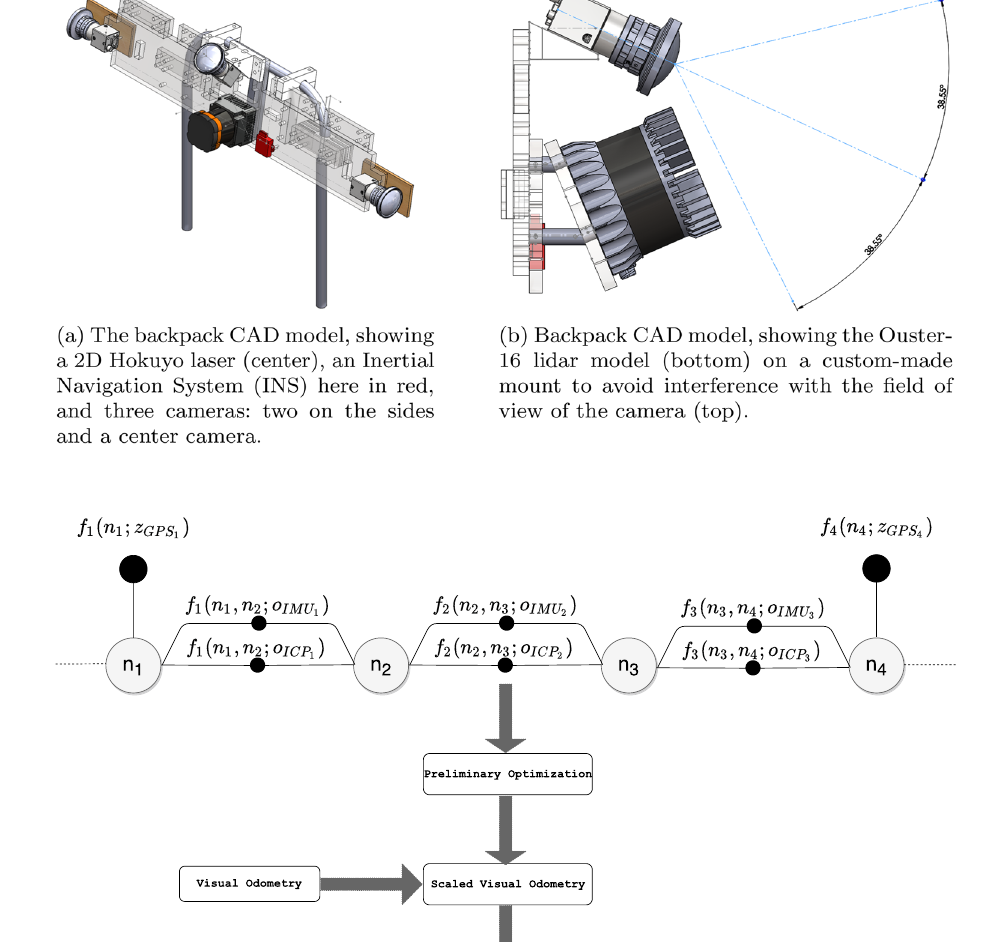
Fig. 3 All fixtures were 3D printed or laser-cut according to a pre-designed CAD model, so that to minimize geometric projection error in between components. The instruments are mounted on a rigid acrylic plate, the latter affixed onto the metal frame of a backpack